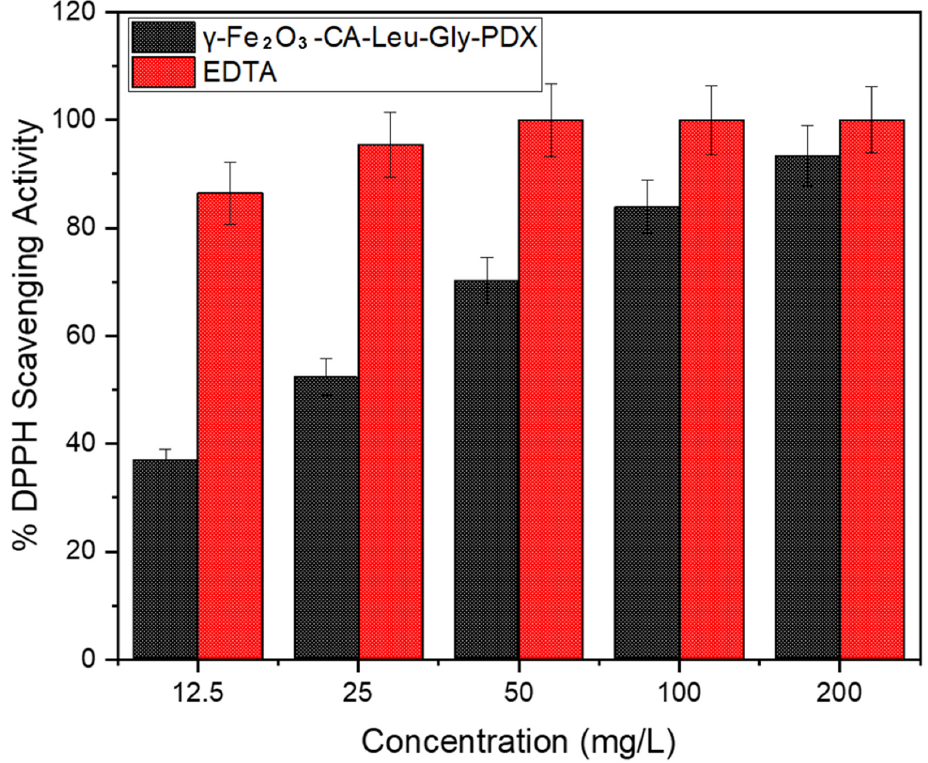
Figure 3. Metal chelating activity of γ‐ Fe 2 O 3 ‐ CA ‐ Leu ‐ Gly ‐